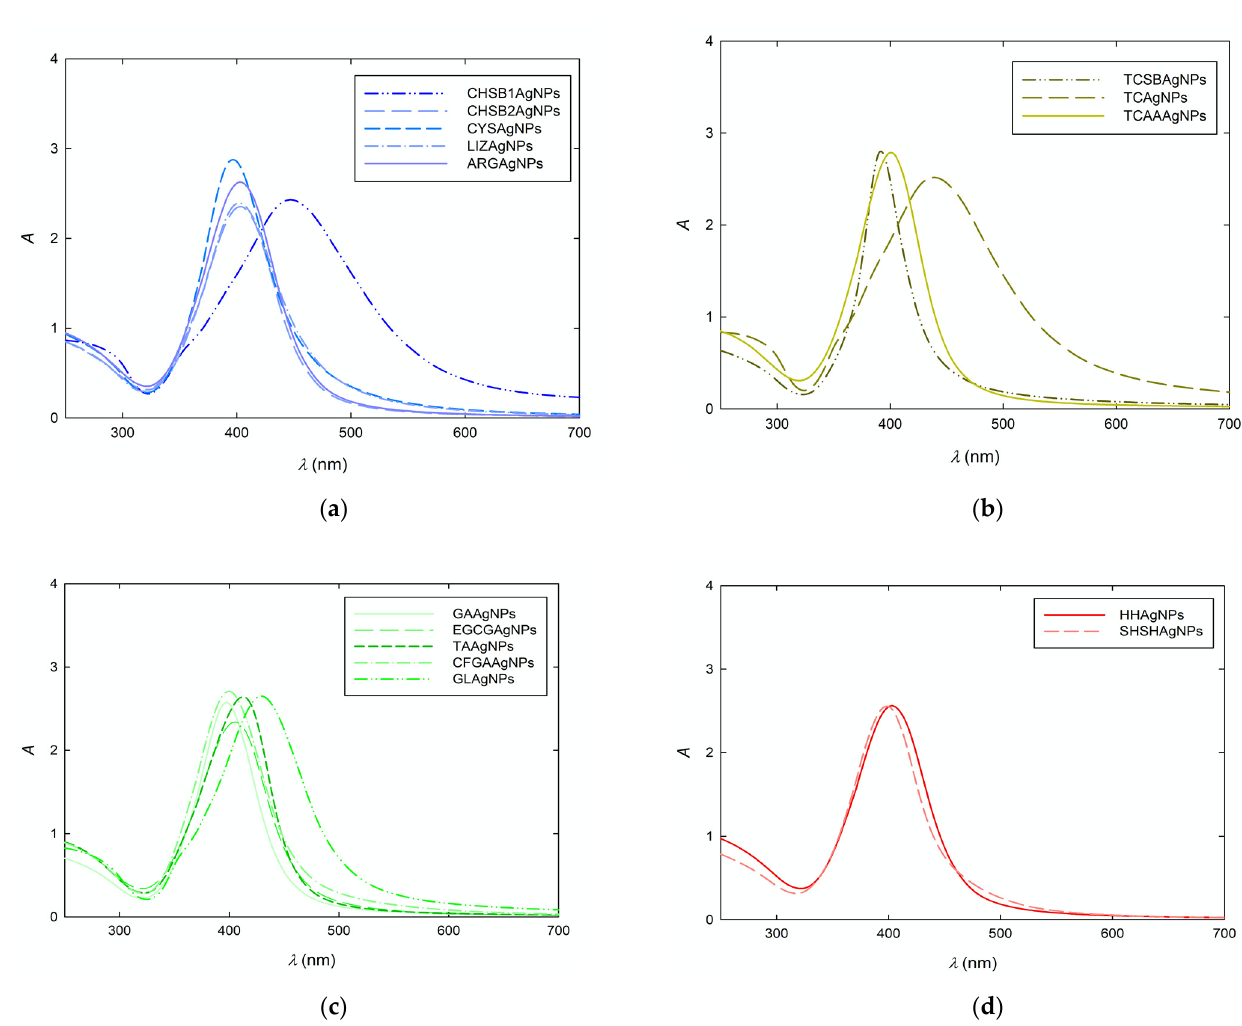
Figure 1. Extinction spectra of diluted AgNP suspensions prepared with the use of ( a ) sodium borohydride (SB); ( b ) trisodium citrate (TC); ( c ) selected antioxidants and glucose (GL); ( d ) inorganic compounds. Table 2. Types of silver nanoparticles (AgNPs) obtained using selected reagents and described reaction conditions. Symbol λ max d